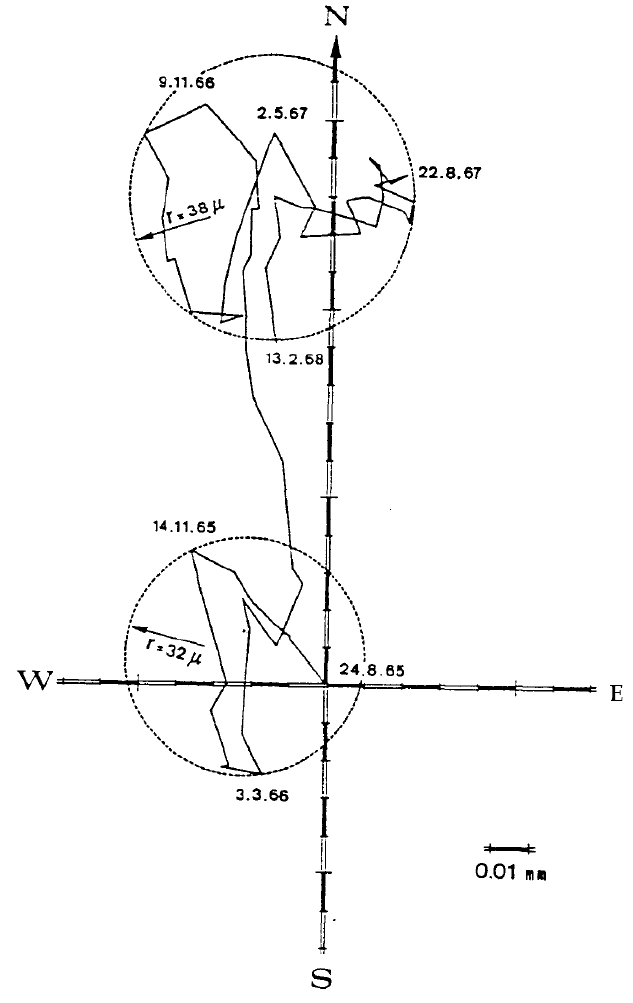
FIG. 25. Horizontal movement of the PS central pillar in 1965–1968 (from Ref.